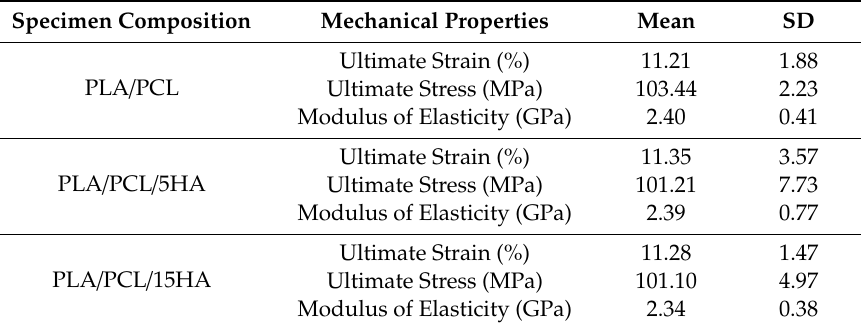
Table 7. Summary of bending